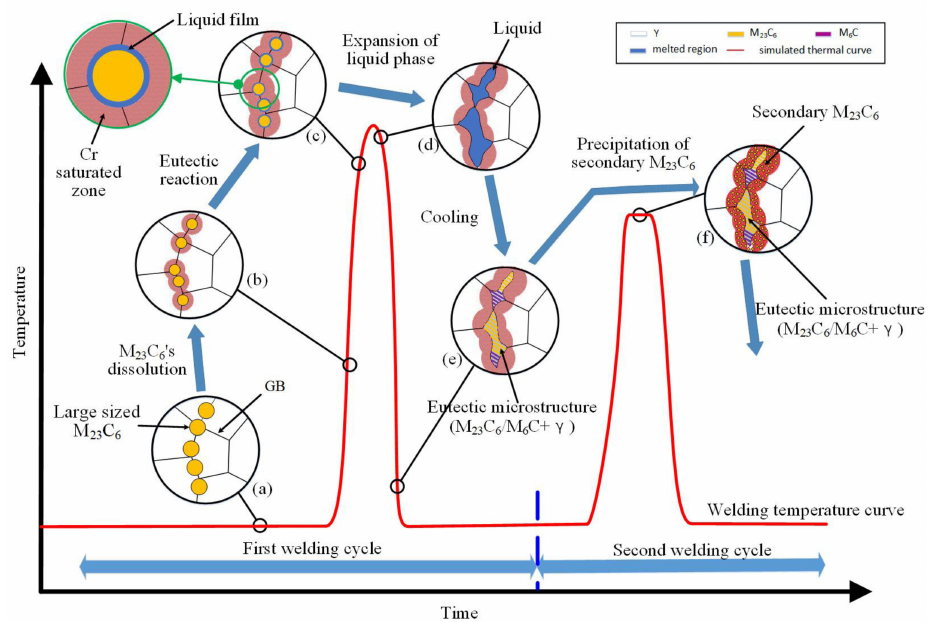
Figure 9. Schematic illustration of M 23 C 6 evolutionary behavior during welding thermal